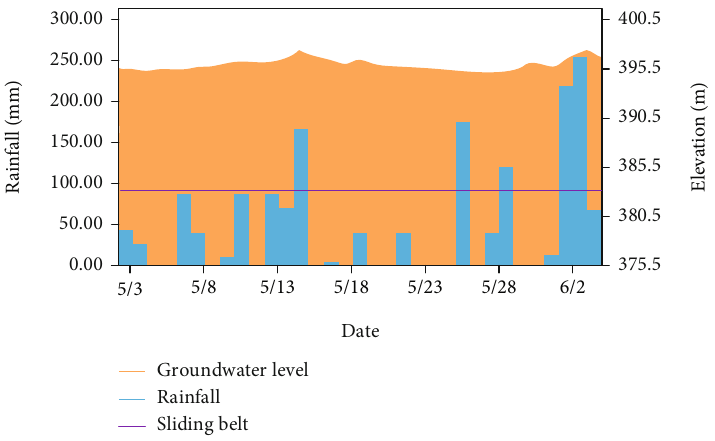
Figure 4: The rainfall and groundwater level monitoring map (P1 hole).